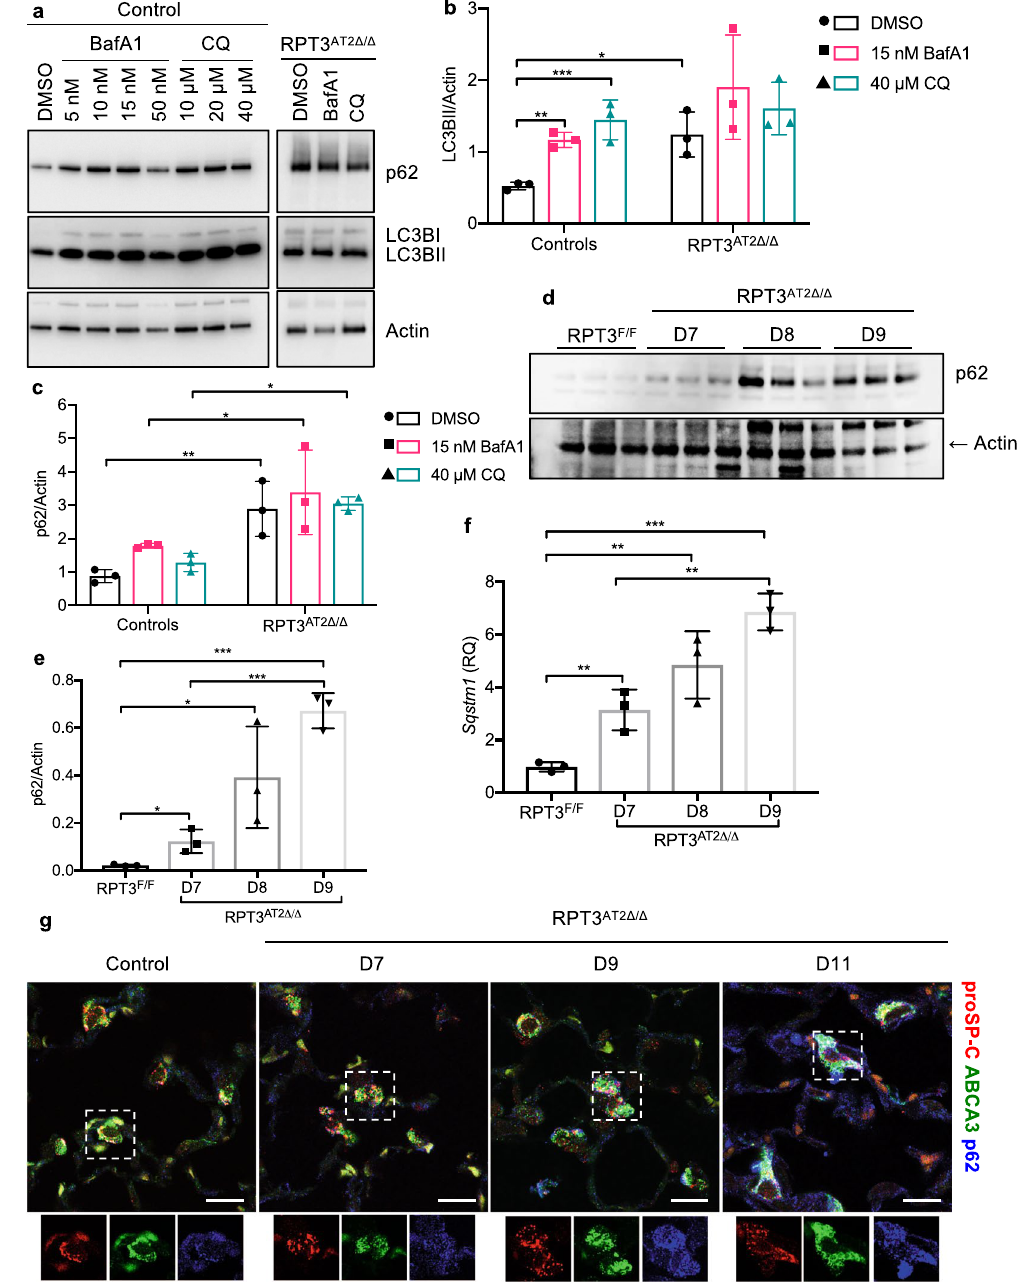
Figure 6. RPT3 deficiency induces p62 expression independent of autophagic activity. ( a ) Representative Western blot and densitometric analysis of LC3BII ( b ) and p62 ( c ) levels from three independent flux experiments. Samples and immunoblots were processed in parallel. Control included Sftpc WT/CreER :RPT3 F/F (RPT3 F/F ) mice without tamoxifen treatment or Sftpc WT/CreER mice that were fed tamoxifen chow for 7 days. * p < 0.05, ** p < 0.01, *** p < 0.001 by two-way ANOVA with Sidak’s multiple comparison test. ( d ) Western blot analysis and densitometry ( e ) of p62 in 30 μ g of AT2 cell lysates separated by SDS-PAGE. ( f ) Quantitative PCR for Sqstm1 (p62) in isolated AT2 cells. RQ: relative quantitation. * p < 0.05, ** p < 0.01, *** p < 0.001 by one-way ANOVA with Tukey’s multiple comparison test. ( g ) Representative single focal plane image of lung sections stained for AT2 cells with proSP-C and ABCA3, and p62. Insets show individual channels for proSP-C, ABCA3, and p62. Scale bars = 10 μ m. Confocal z-stacks were deconvoluted to obtain final images (details in methods). Controls included both RPT3 F/F mice ( Sftpc WT/CreER :RPT3 F/F mice without tamoxifen treatment) and Cre mice that were fed tamoxifen chow for 7 days. Full-length blots are presented in Supplementary Fig.